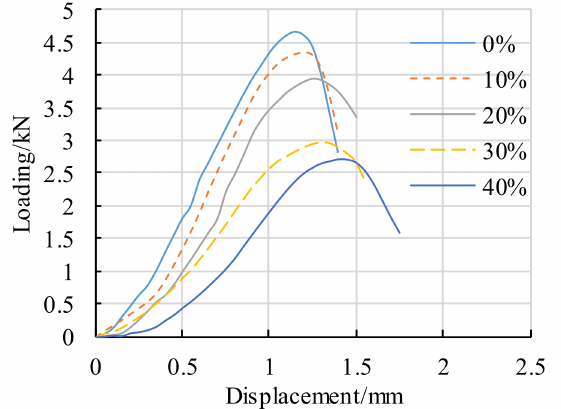
Figure 6. Loading to displacement curves of direct tensile